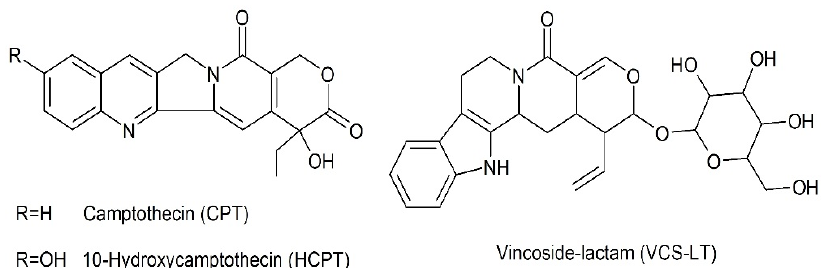
Figure 1. Chemical structures of CPT, HCPT, and VCS ‐ LT.